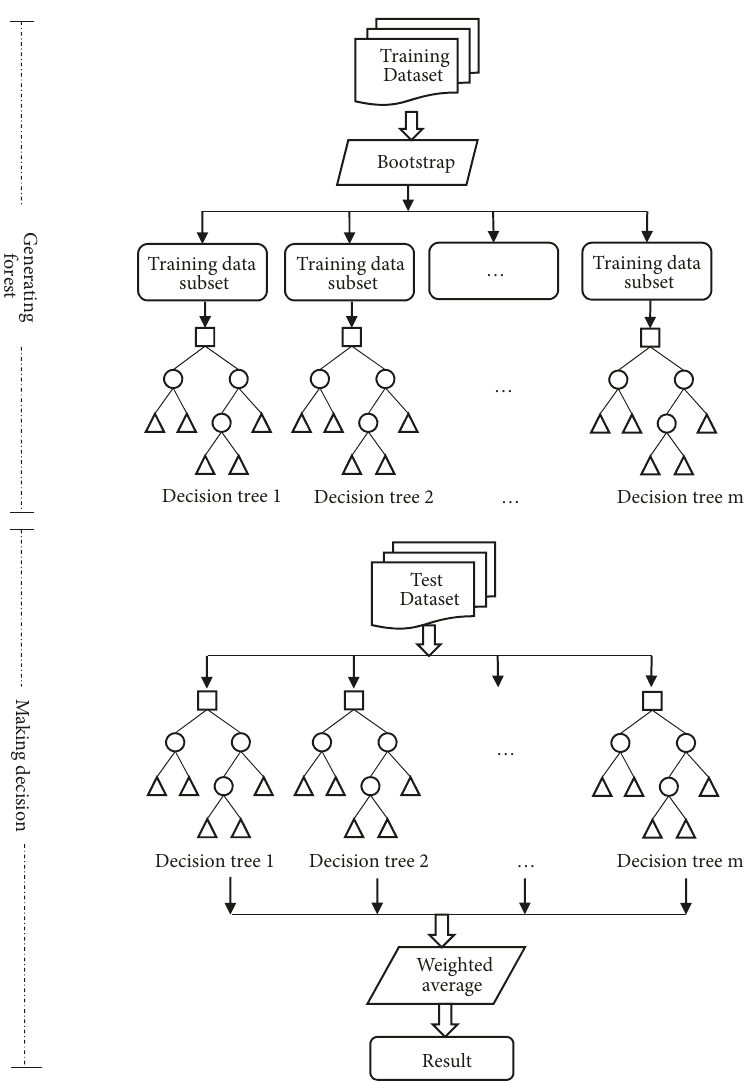
Figure 1: The process of establishing a Random